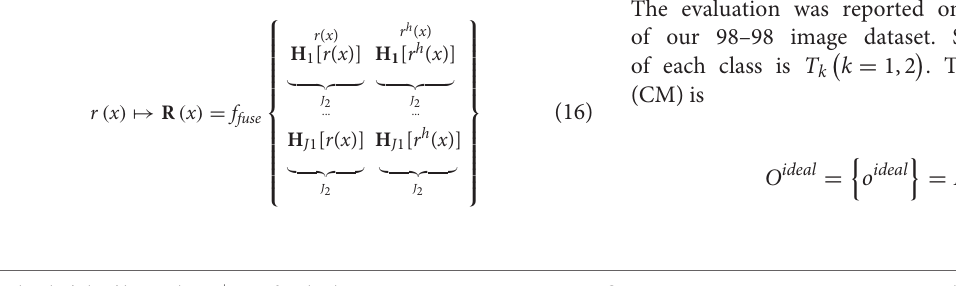
are combined. The r h ( x ) i h